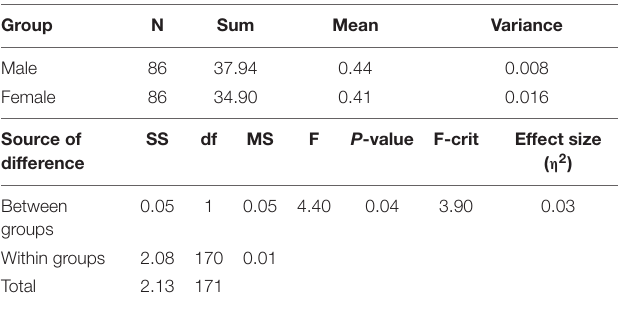
TABLE 6 | Variance analysis of gender